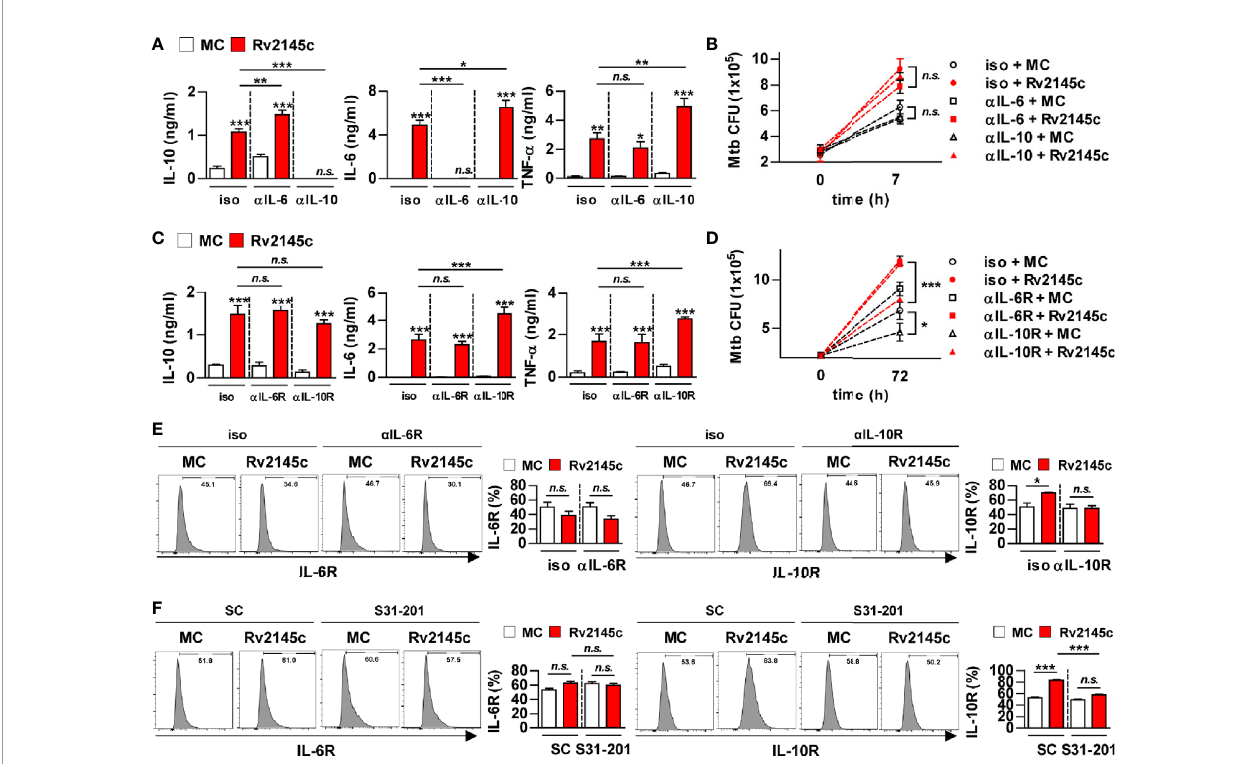
FIGURE 7 | Rv2145c enhances intracellular Mtb growth via IL-10 receptor signaling. (A-E) BMDMs were pretreated with anti-IL-6 ( a IL-6, 5 m g/ml) antibody, anti-IL- 10 ( a IL-10, 5 m g/ml) antibody, mouse control IgG (iso, 5 m g/ml) for cytokine neutralization or anti-IL-6R ( a IL-6R, 1 m M), anti-IL-10R ( a IL-10R, 1 m M) or mouse control IgG (iso, 1 m M) for receptor blocking, and then BMDMs were infected with Mtb at an MOI of 1 for 4 and treated with 10 m g/ml Rv2145c. Then, the cells were cultured in the presence of each neutralizing antibody or receptor blocking antibody for 72 h. (A, C) IL-10, IL-6, and TNF- a levels in the culture supernatants were measured by ELISA. (B, D) Intracellular Mtb growth was determined by plating the cell lysates on 7H10 agar at 0 h and 72 h. (E) The expression of receptor markers was analyzed by two-color fl ow cytometry. The cells were gated to exclude F4/80 + cells. BMDMs were stained with anti-IL-6R or anti-IL-10R antibodies. (F) BMDMs pretreated with inhibitors of STAT3 (S31-201, 5 m M) for 1 h and then infected with Mtb at an MOI of 1 for 4 h and treated with 10 m g/ml Rv2145c, and then the cells were incubated in the presence and absence of S31-201 for 72 h. The expression of the receptor markers was analyzed by two-color fl ow cytometry. The cells were gated to exclude F4/80 + cells. BMDMs were stained with anti-IL-6R or anti-IL-10R antibodies. The bar graphs show the percentage (mean ± SD of three experiments) for each surface molecule on F4/80 + cells. * p < 0.05, ** p < 0.01, and *** p < 0.001 for treatment compared with medium controls (MC) or for the difference between treatment data. n.s., no signi fi cant